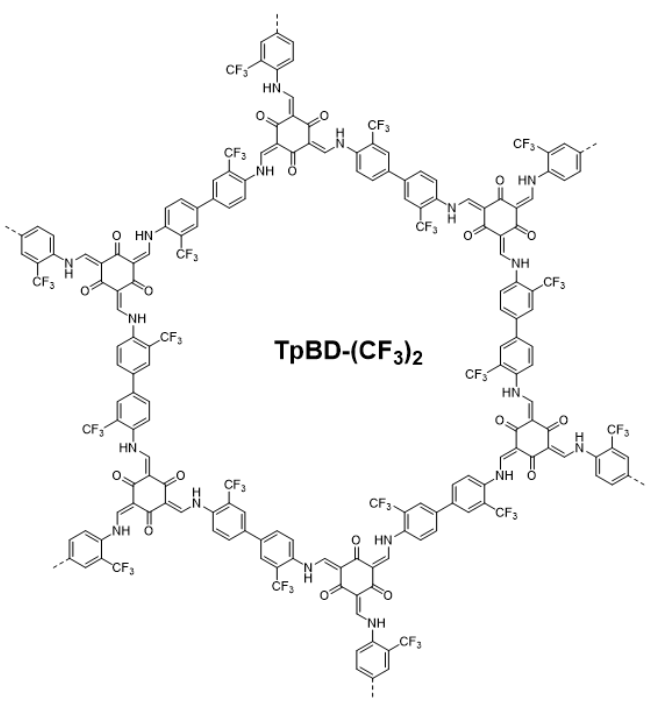
Figure 1. The pore structure of TpBD-(CF 3 ) 2 . Table 1. Properties of the studied pharmaceuticals. Dimensions of pharmaceuticals were obtained by measuring the furthest distances of C, N, or O atoms from the X-ray crystal structures obtained from the Cambridge Structural Database (CSD) with the following codes: a CCDC 1041382, b CCDC-1149948, c CCDC-150969. Ibuprofen Phenobarbital